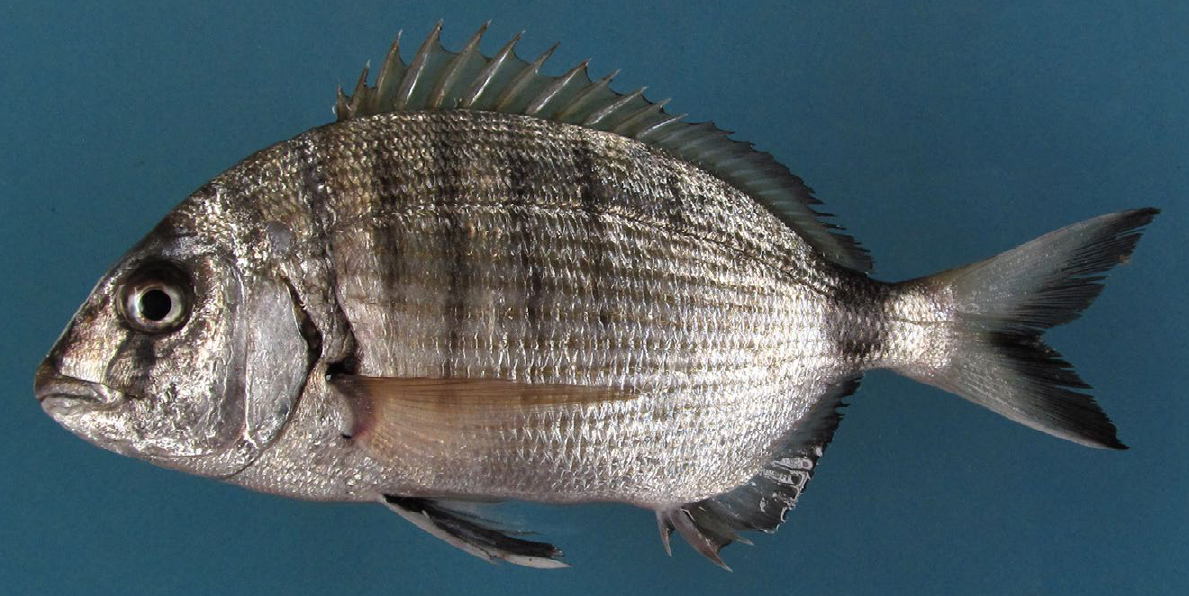
Fig. 1. – Diplodus levantinus n. sp., HUJ 20535, holotype, 184.1 mm SL, off Jaffa, Israel, 30 Oct. 2015. Lateral view; photograph of the fresh colouration taken a few hours after collection (Photograph: D.